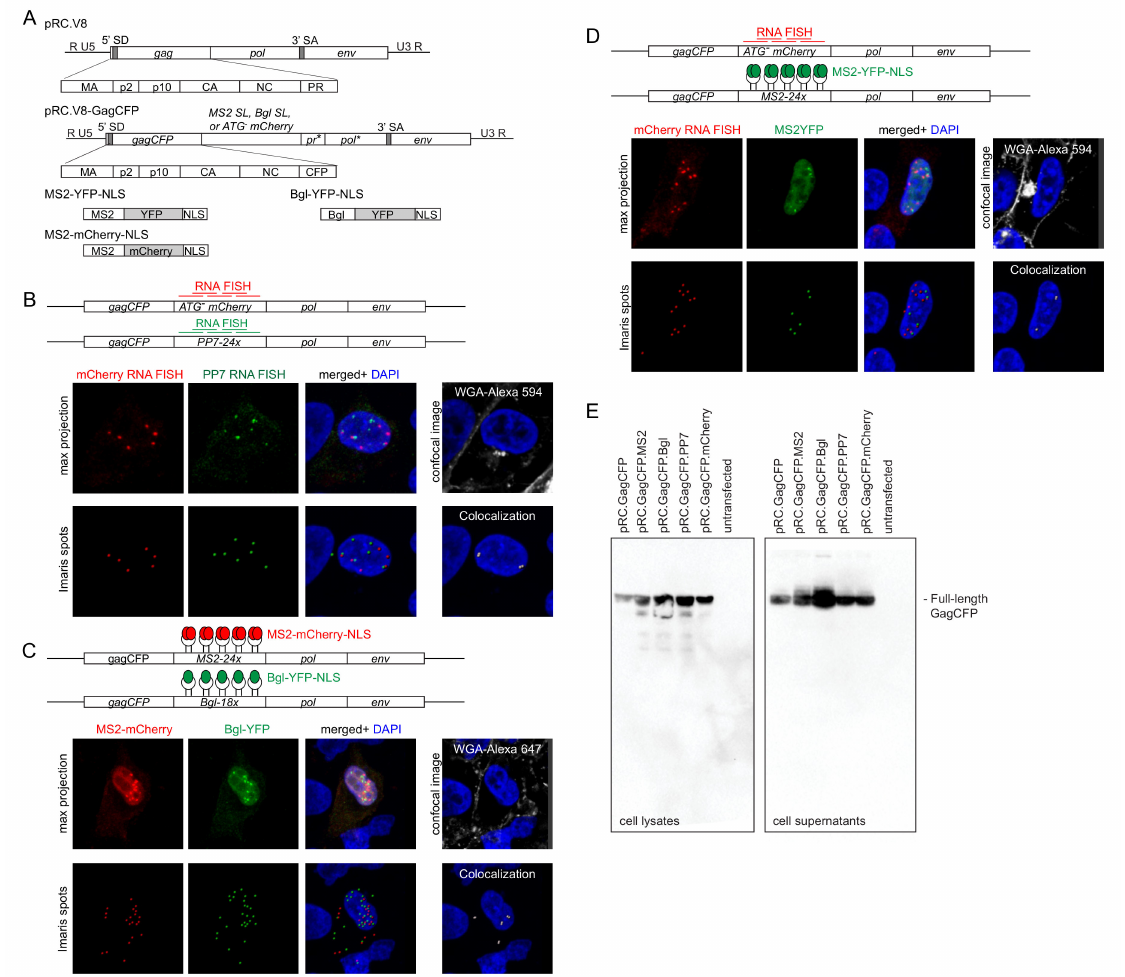
Figure 1. Three approaches to visualize genome dimerization in Rous Sarcoma virus (RSV). ( A ) Schematic of pRC.V8, the wild-type RSV proviral construct that forms the backbone plasmid that was modified to generate pRC.V8.GagCFP, which contains CFP fused to NC, disrupting the gagpol reading frame, resulting in a non-functional PR and pol (designated as pr * and pol *). pRC.V8.Gag-CFP contains insertion of either RNA binding stem-loops (MS2SL or BglSL) or a non-coding mCherry (ATG- mCherry) sequence. Below are schematics of the fluorophore-fused MS2 and Bgl binding proteins, which contain an NLS; ( B ) In the first approach, proviral constructs containing a noncoding mCherry sequence (pRC.GagCFP.ATG-mCherry) or PP7-derived sequence encoding RNA stem-loops (pRC.GagCFP.PP7) were co-transfected, each serving as a target for specific smFISH probes labeled with Alexa 647 (against mCherry; red) or Alexa555 (against PP7, green). WGA-Alexa 594 (gray) staining was used to outline the plasma membrane (image shown is a single z-plane); ( C ) In the second approach, proviral constructs containing the noncoding mCherry sequence (pRC.GagCFP.ATG-mCherry) were detected by smFISH probes labeled with Alexa 647 (red) or MS2 aptamer encoding RNA stem-loops (pRC.GagCFP.MS2) bound by the MS2-YFP protein (green). WGA-Alexa 647 staining was used to outline the plasma membrane (image shown is a single z-plane); ( D ) In the third approach, proviral constructs containing either the MS2 cassette (pRC.GagCFP.MS2) or Bgl RNA stem-loops (pRC.GagCFP.Bgl) were bound by either MS2-mCherry (red) or Bgl-YFP (green), respectively. WGA-Alexa 594 staining shown in gray outlined the plasma membrane (image is a single z-plane). In each vRNA labeling combination, only unspliced vRNAs were labeled. Representative microscopy images are shown for each condition. Images were obtained as z-stacks through the width of the cell using a 63 × objective at 3.5 × optical zoom. Foci were identified using the “Spot Function” in Imaris. Colocalization between RNA foci was determined as described in the Materials and Methods. Image histograms were adjusted in the Imaris software for ease of visualization; ( E ) The proviral constructs used were budding competent, as shown by immunoblotting using RSV anti-CA antibody to detect full-length Gag-CFP in cell lysates ( left ) and supernatants ( right